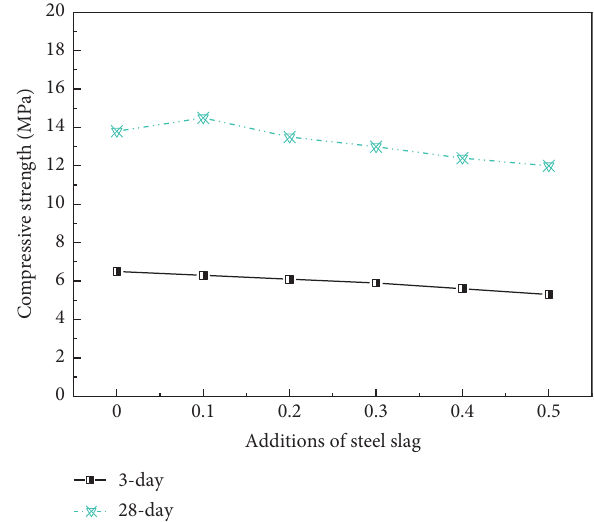
Figure 11: The compressive strength of the waste sediment-based grouting material with different addition amounts of steel